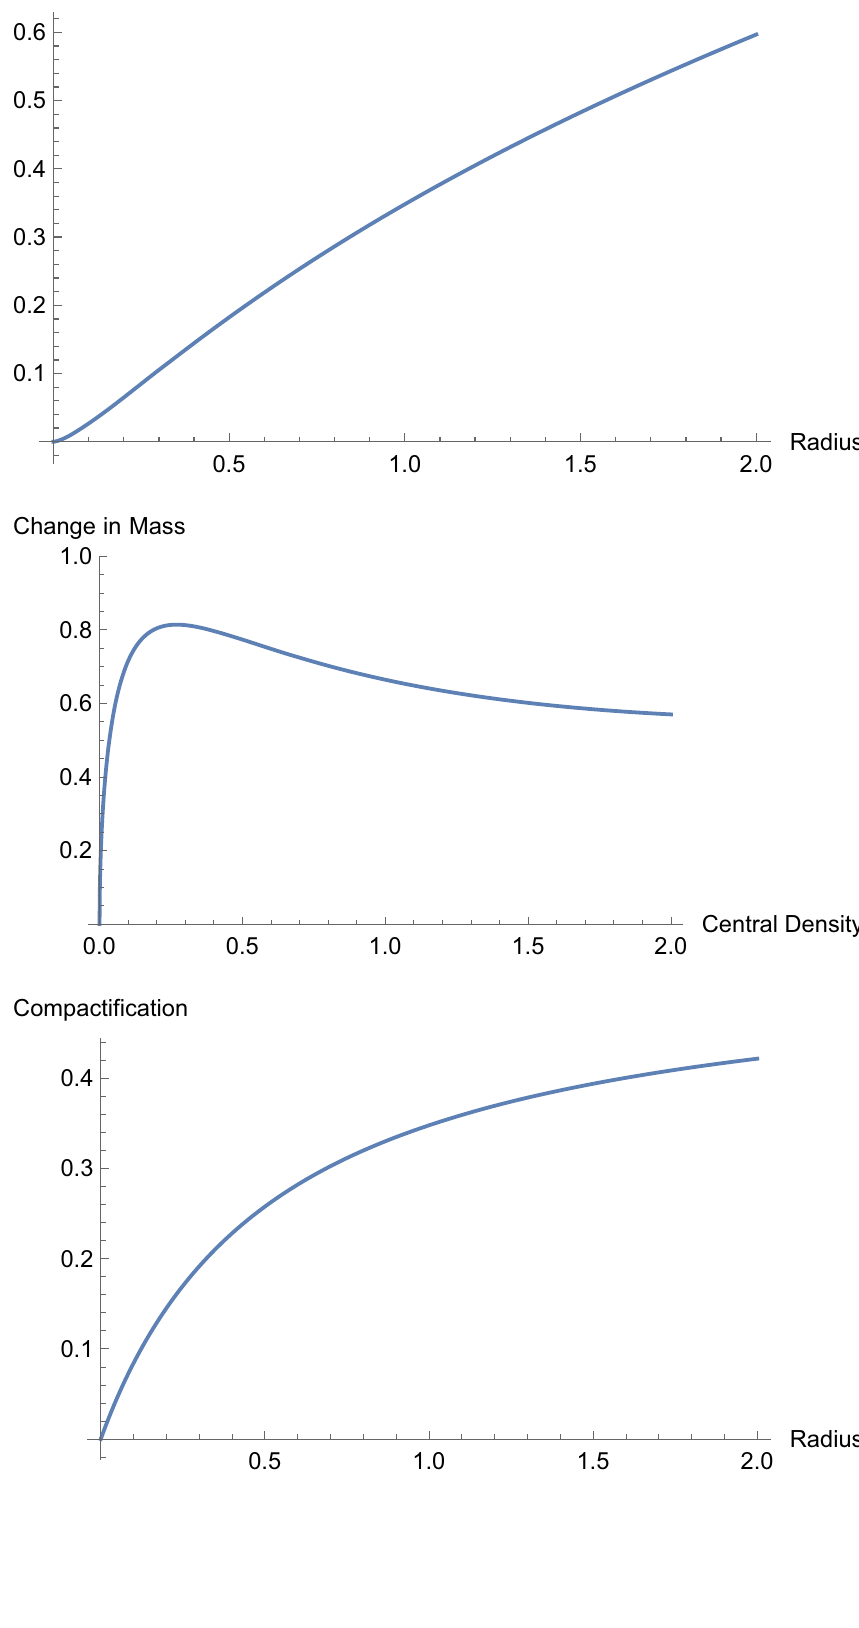
Fig. 17 Change in mass dM versus the central density ρ 0